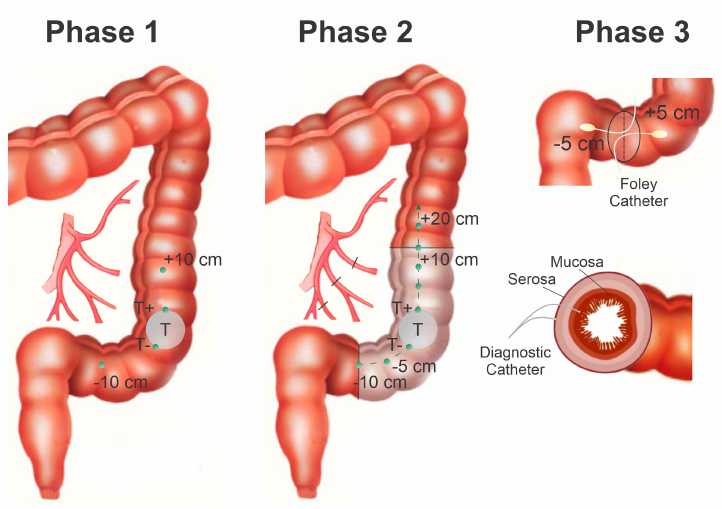
Figure 2. Scheme of the surgery with marked points for measuring the tissue saturation. Points 0 cm and 20 cm were the boundaries of the anastomosis. Tissue saturation of the tumor was measured at three points, where T − and T+ tumor borders, and T is the center of the tumor. The section of the intestine to be reshaped is highlighted in white. Black borders are the border of the anastomosis. At points +5 cm and − 5 cm, the spectra of diffuse reflectance, transmission, and the degree of StO 2 were measured when a Foley catheter with a cylindrical diffuser was inserted into the